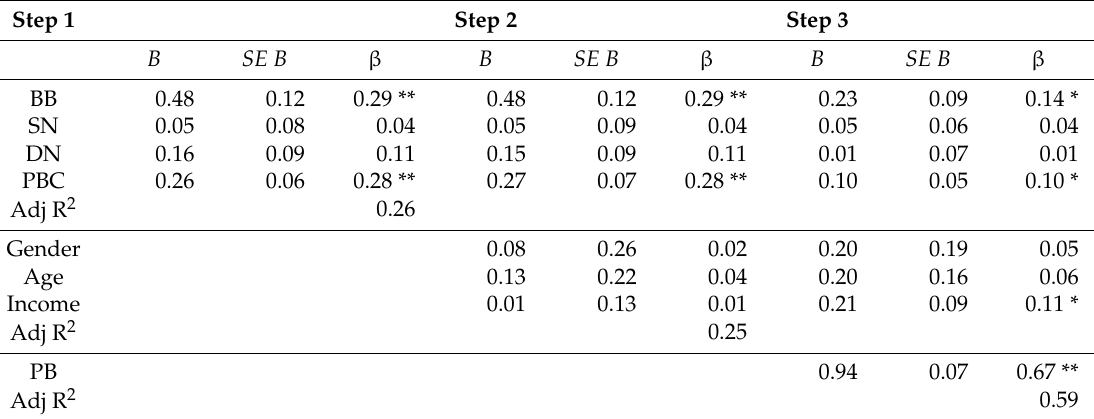
Table 3. Prediction of the intention to travel by bus. Hierarchical logistic regression